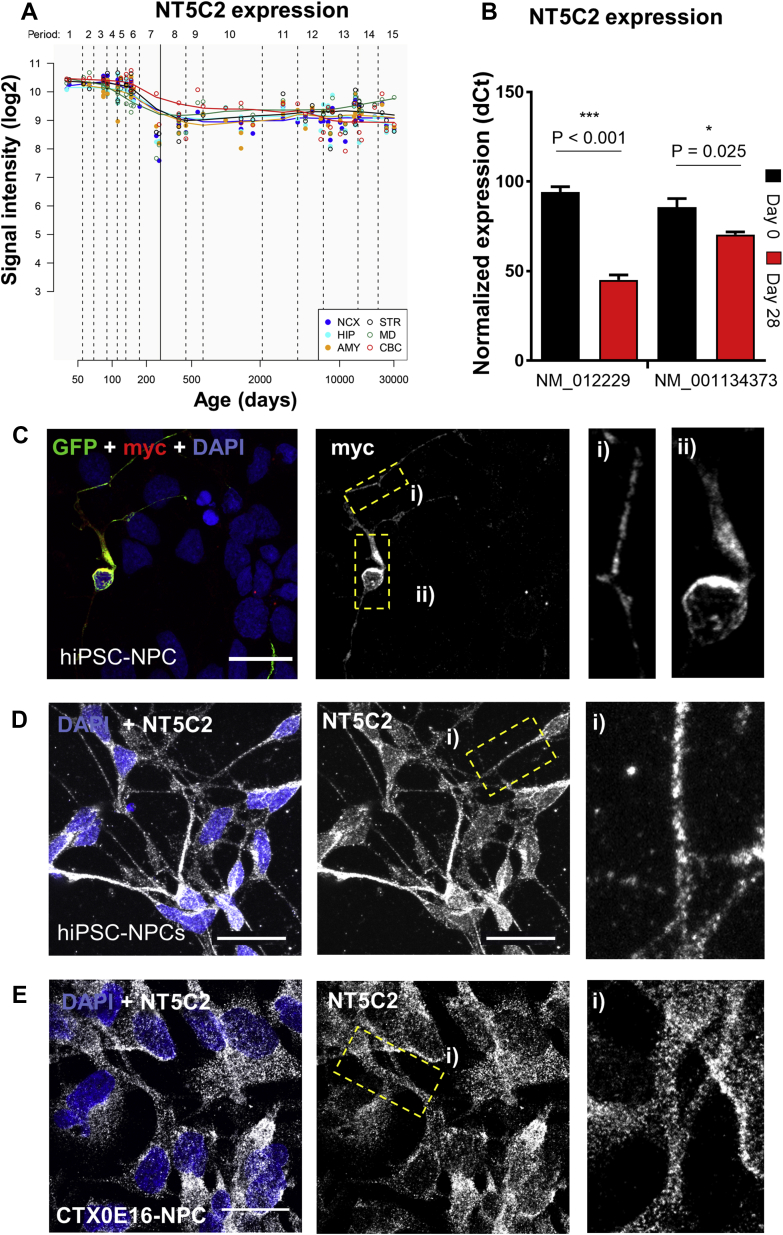
Neurodevelopmental expression of NT5C2 and protein distribution in human neural progenitor cells (hNPCs). (A) Neurological expression of NT5C2 across human development, according to the Human Brain Transcriptome Atlas (46), showing that expression peaks during fetal development. (B) Expression of NT5C2 RefSeq transcripts NM_012229 and NM_001134373 in hNPCs (day 0) and cultures differentiated for 28 days. Expression is significantly higher at the neural progenitor state. t tests: ***p < .001, *p < .05. (C) Distribution of ectopic NT5C2 was assessed by transfecting hNPCs with plasmids encoding NT5C2-myc and enhanced green fluorescent protein (GFP), followed by immunolabeling using antibodies raised against myc or GFP (GFP was used as morphological marker). (D) Subcellular localization of endogenous NT5C2 in hNPCs derived from a human induced pluripotent stem cell (hiPSC) line and from (E) the CTX0E16 cell line. NT5C2 was ubiquitously distributed in hNPCs from both models. Scale bars = 20 μm. AMY, amygdala; CBC, cerebellar cortex; dCt, delta cycle threshold; HIP, hippocampus; MD, mediodorsal nucleus of the thalamus; NCX, neocortex; STR, striatum.